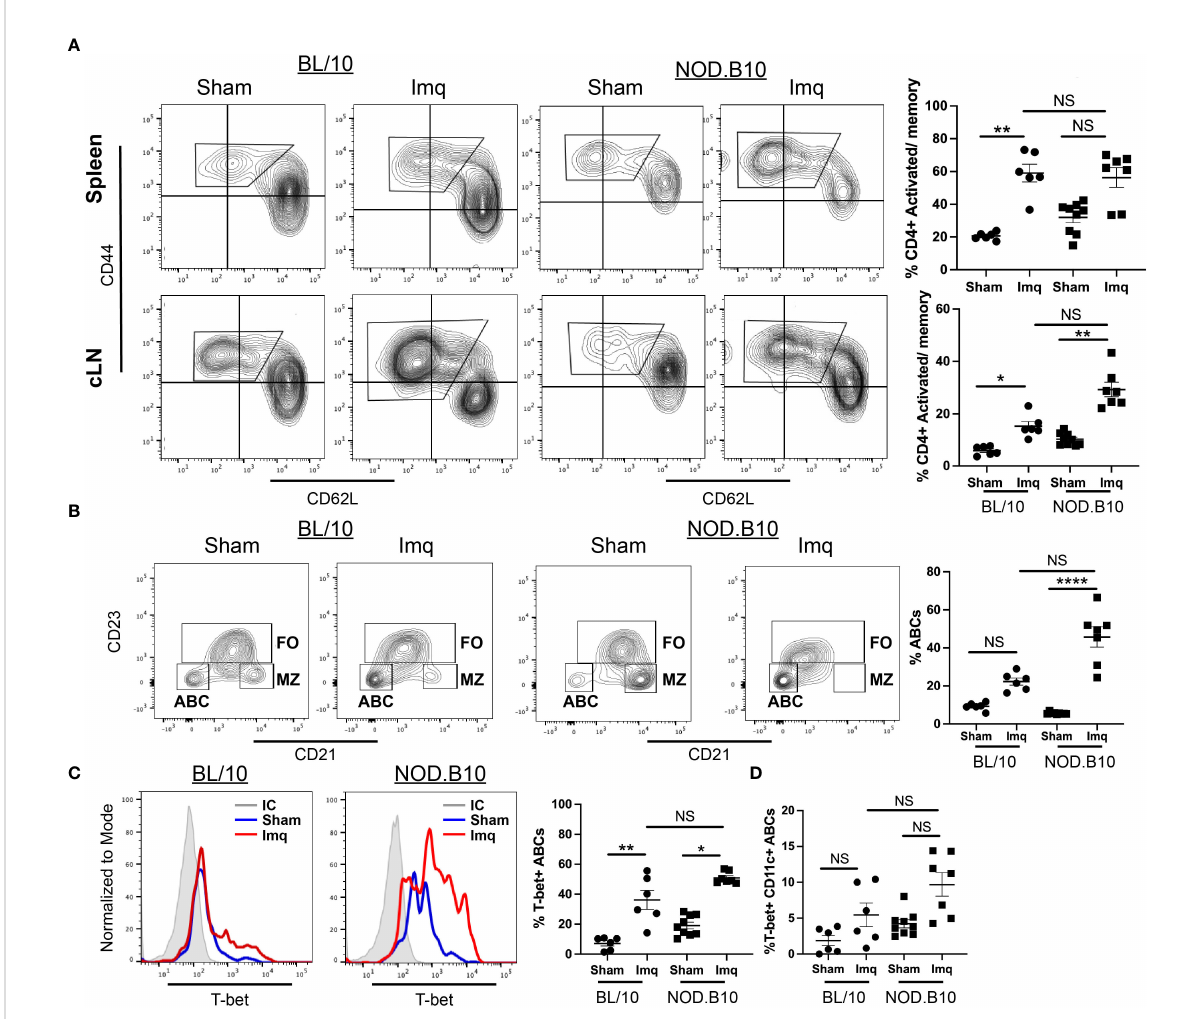
FIGURE 6 Activated/memory T cells and T-bet-expressing B cells are expanded in secondary lymphoid organs of pSS mice. Spleens and cLNs of sham (n = 9) or Imq-treated NOD.B10 mice (n = 7) and from sham (n = 6) or Imq-treated age and sex-matched controls (n = 6) were harvested and fl ow cytometry was performed. (A) Cells were gated on CD4 and CD44 and CD62L expression is shown. The percentages of activated/memory T cells (CD4 + , CD44 + , CD62L - ) from spleen and cLNs are shown. (B) The percentages of ABCs (B220 + , CD21 - , CD23 - ) were quanti fi ed. ABCs were gated and expression of (C) T-bet and (D) Tbet/CD11c are shown. Plots from one representative animal from each group is shown. Horizontal lines represent mean and SEM (NS, non-signi fi cant, *p < 0.05, **p < 0.01, ****p <